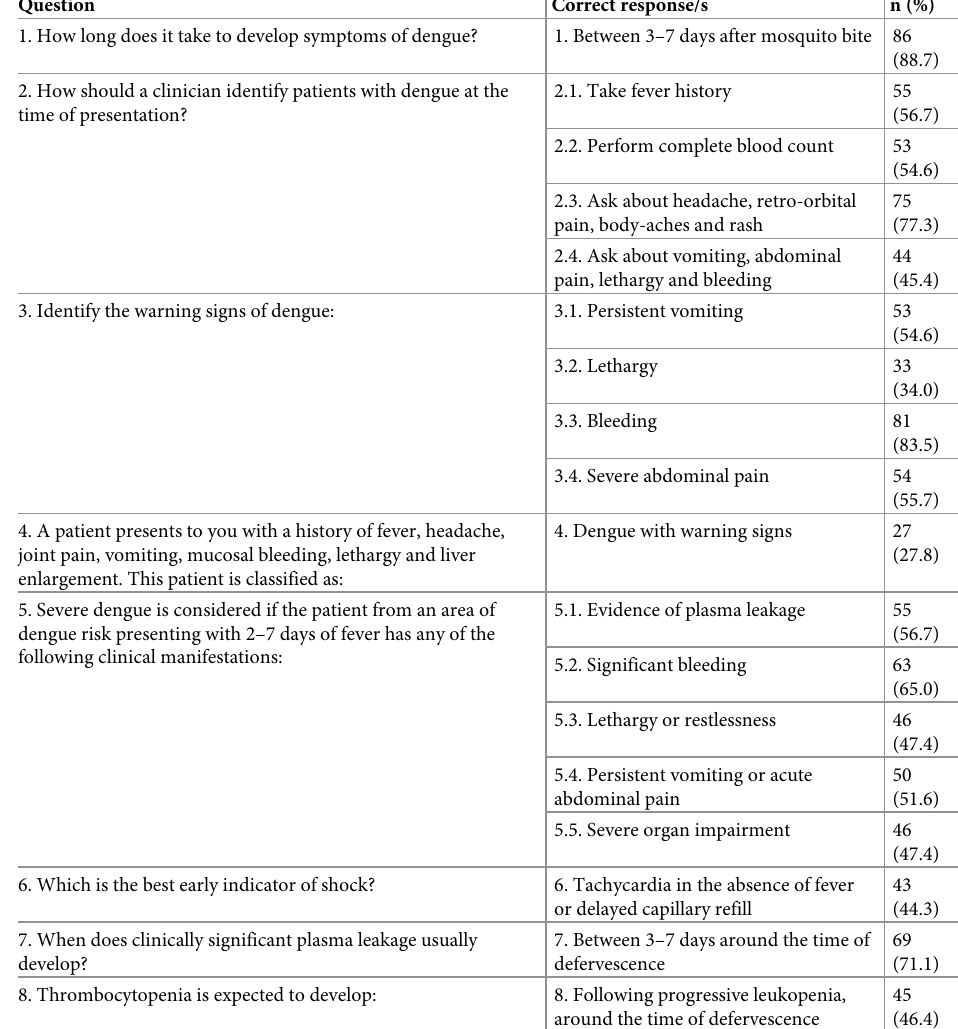
Table 3. Knowledge of clinical course/presentation of dengue (domain 2), Bhutan,